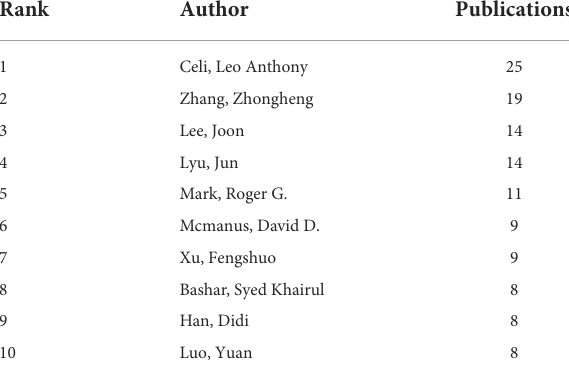
TABLE 3 Top 10 authors in terms of the publication